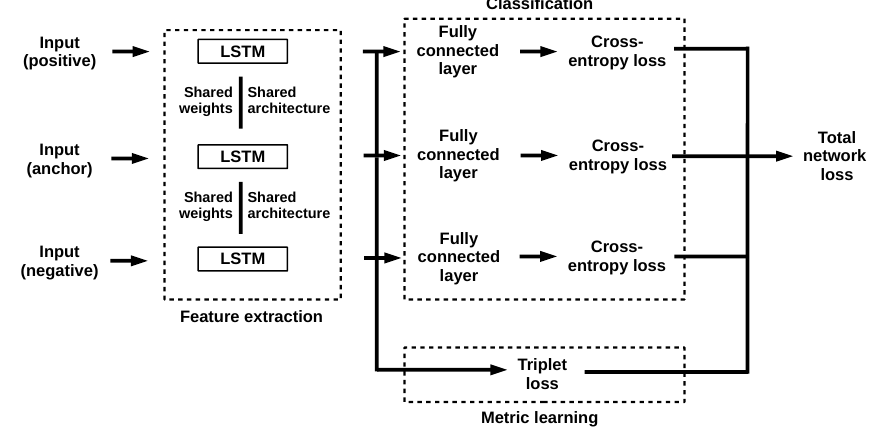
Figure 2. The overall network architecture of the proposed